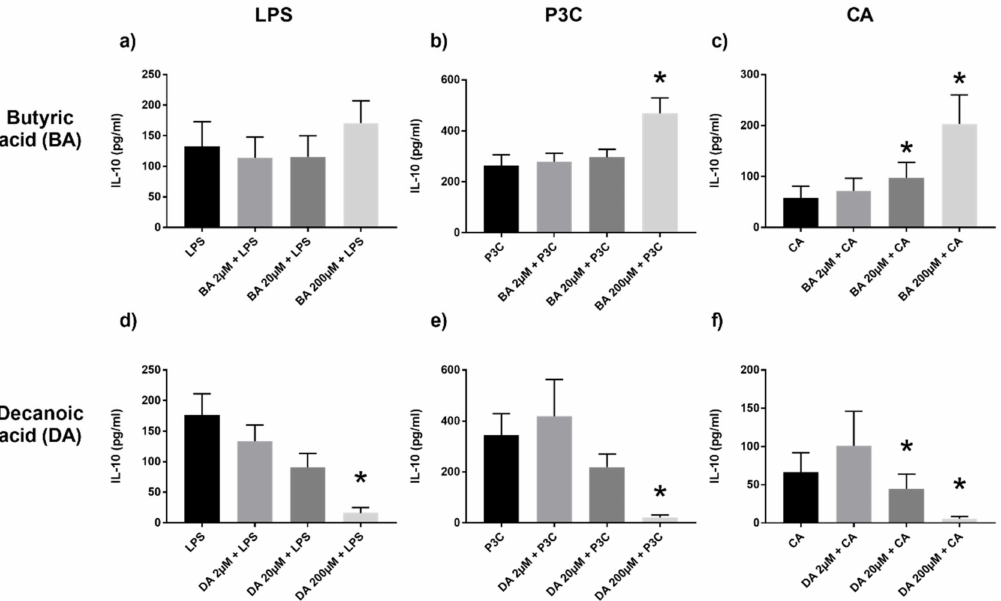
Figure 4. IL-10 production in PBMC stimulated with various dilutions of butyric (BA) ( a – c ) or decanoic acid (DA) ( d – f ) and LPS, P3C, or CA, assessed by ELISA. Values are presented as mean ± SEM, results from at least 7 subjects were used. Wilcoxon signed rank test to determine significance for pair-wise comparisons with the control group, * p < 0.05 is the cytokine level difference compared to the control LPS/P3C/CA group (black